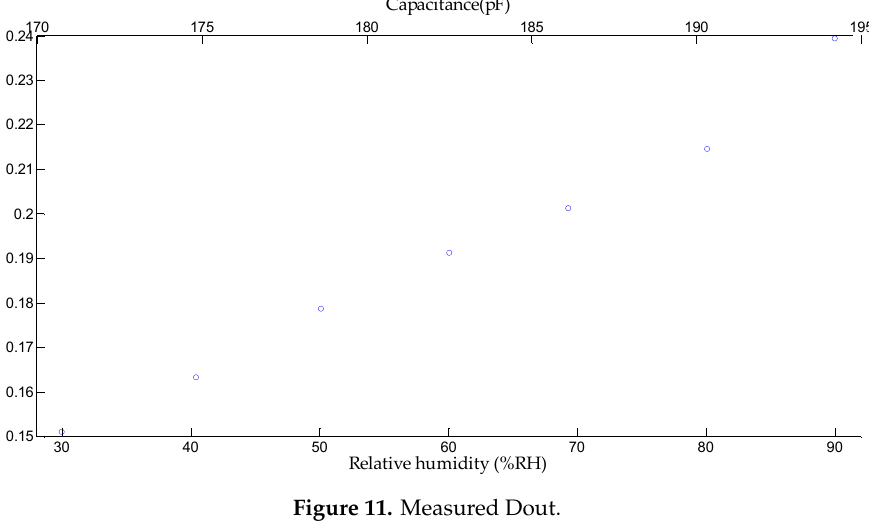
Figure 11. Measured Dout.